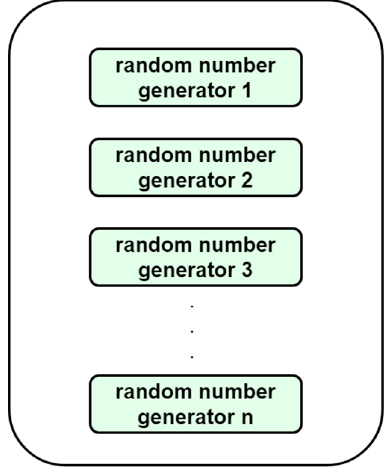
Figure 5. The structure of a large-scale chaos random number generator (CRNG).